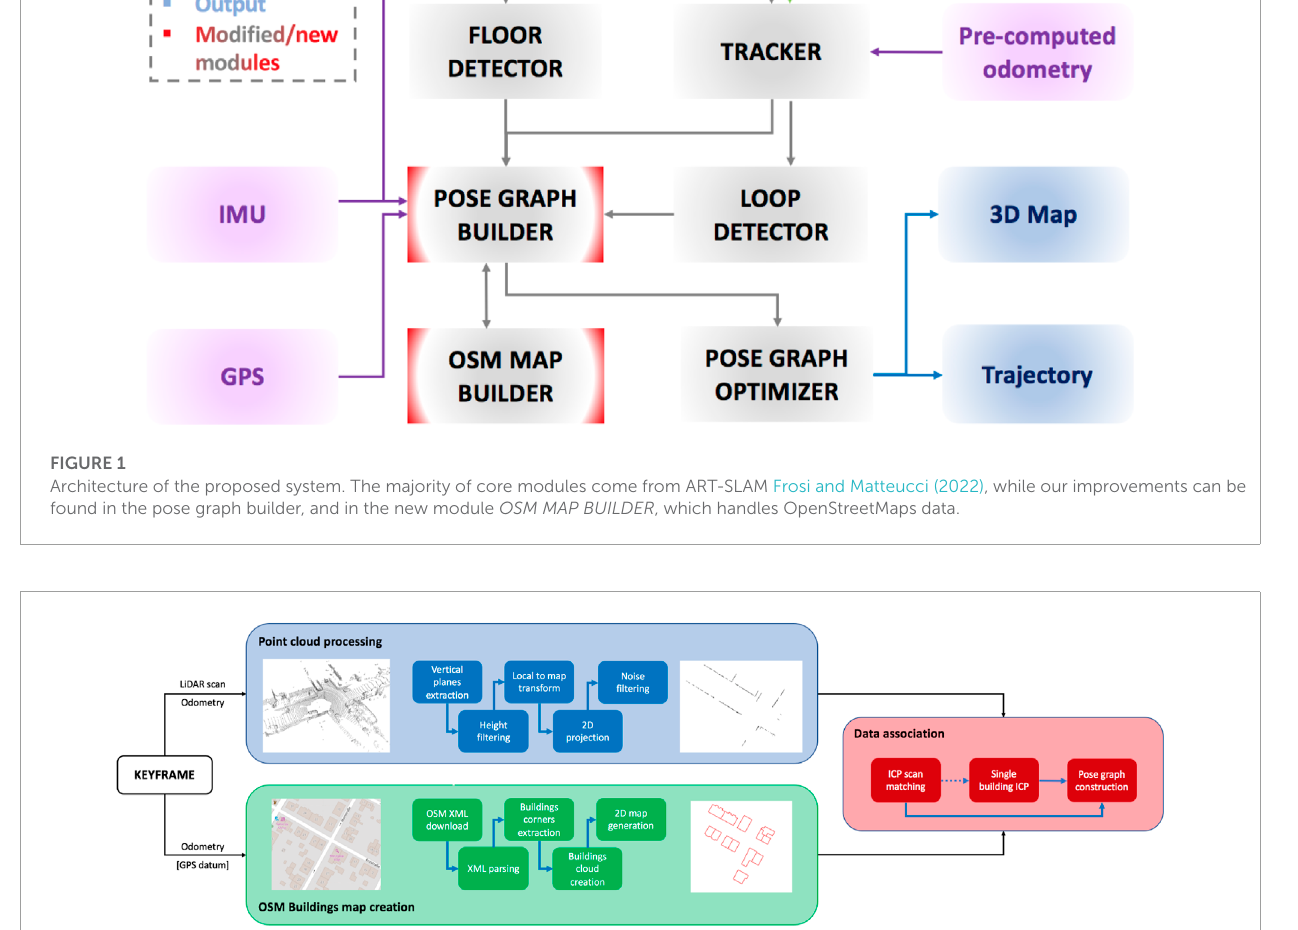
FIGURE 2 High-level pipeline describing the contribution of the proposed system. The whole procedure happens during the pose graph construction, before optimization takes place.